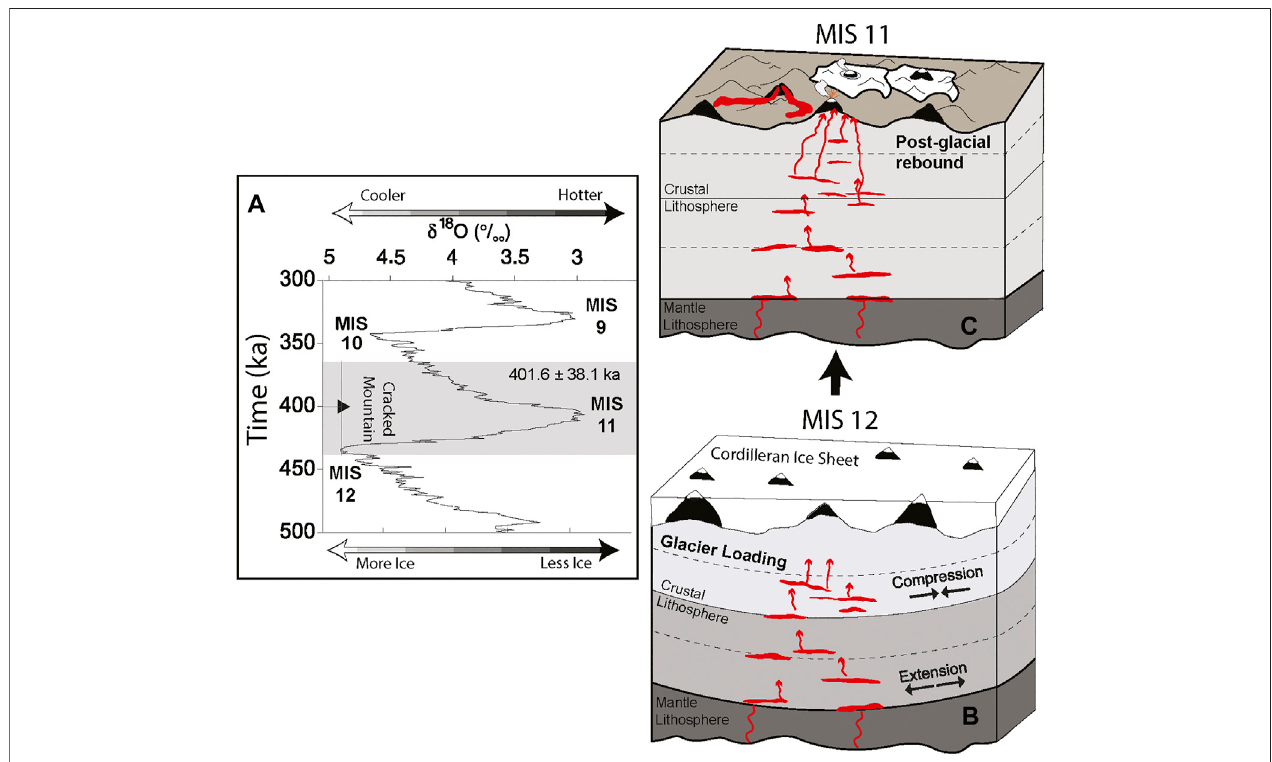
FIGURE 10 | A causal relationship between magma-crustal dynamics and glaciation for the Cracked Mountain eruption. (A) Mid Pleistocene Marine δ 18 O ( o / oo ) isotope record (MIS), modi fi ed from Lisiecki and Raymo (2005); Harris et al., 2022, showing fl uctuations (and numbered stages) in global ice from, where higher δ 18 O represents periods of more global ice and lower δ 18 O represents periods of lower global ice. The vertical axis is a record of time (ka) with magnetic pole orientations shown through the Pleistocene. The Cracked Mountain plateau age of 401.6 ± 38.1 ka is plotted (grey shaded) on the blow-up MIS portion, representing times from the waning ofMIS 12through MIS 11 (B,C) . Schematic magmaascent dynamics are depictedfor crustal loading (B) and unloading (C) during cycles ofglaciation, modi fi ed from Wilson and Russell